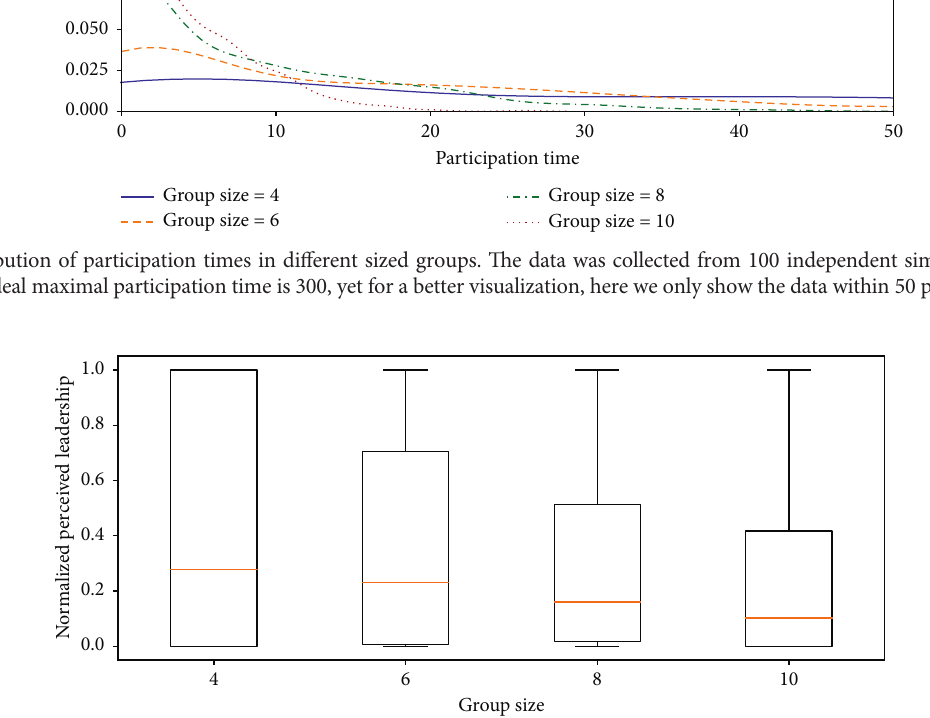
, ... , PL 300 )] / [ max ( PL 300 , ... , PL 300 ) − min ( PL 300 , ... ,PL 300 )] , where PL 300 n n n i is the perceived 1 1 1